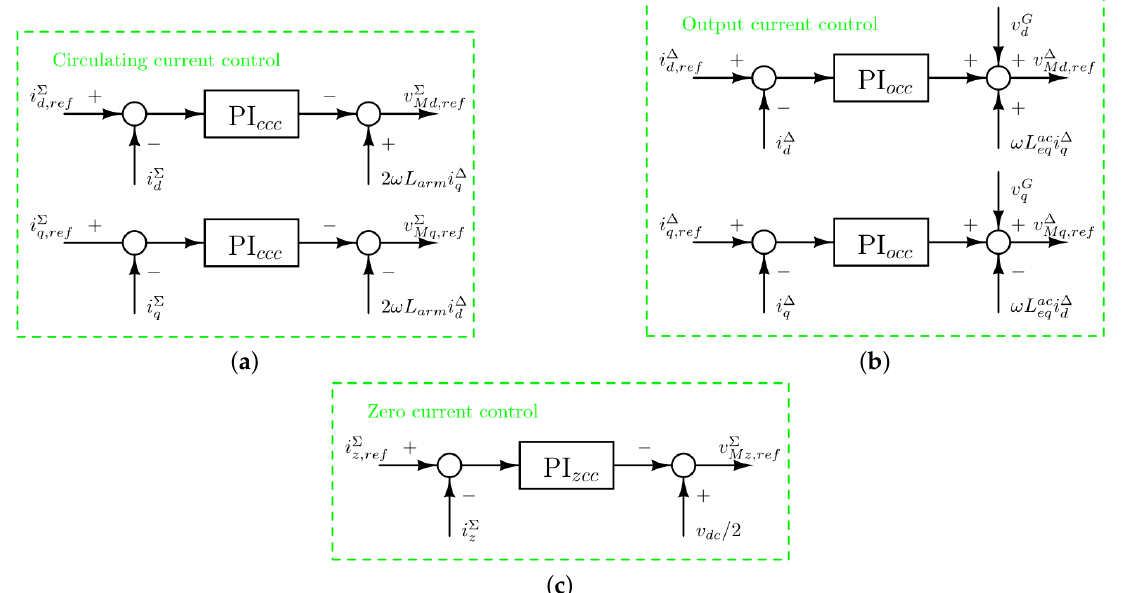
Figure 3. MMC’s inner PI controlling loops for ( a ) circulating current, ( b ) output current, and ( c ) zero